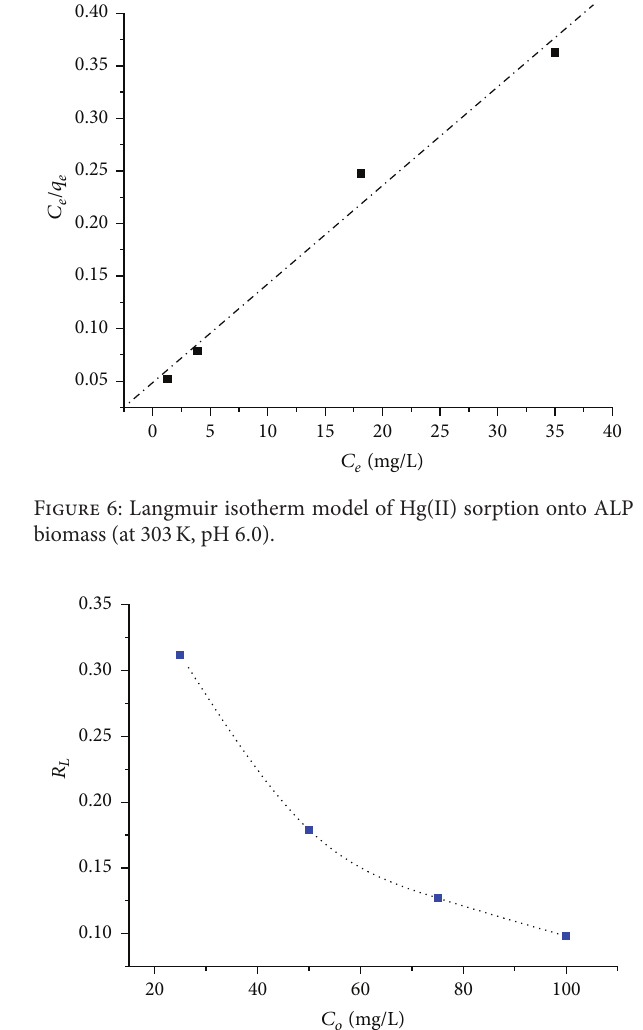
Figure 7: Separation factor for adsorption of Hg(II) by ALP